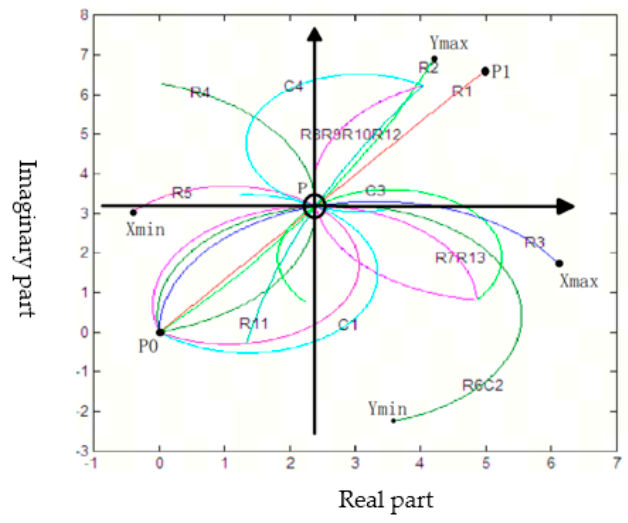
Figure 6. Feature normalization based on the circle model.